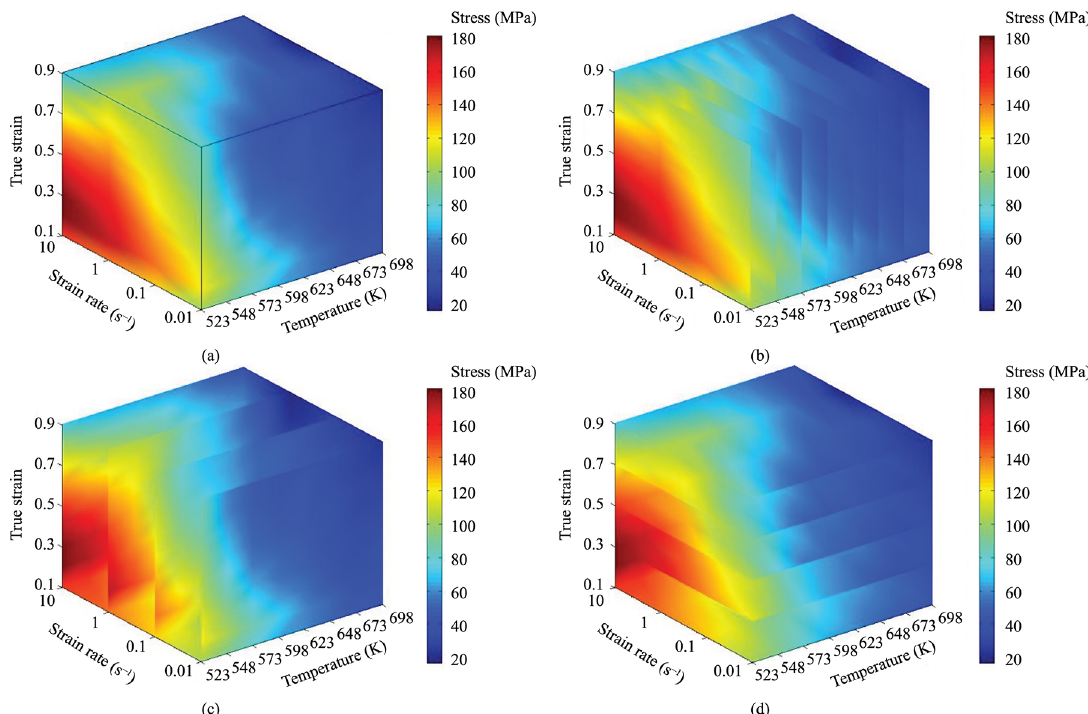
Figure 12. The (a) three-dimensional prediction map of flow stress and the cross profiles at different (b) temperatures, (c) strain rates and (d) strains.